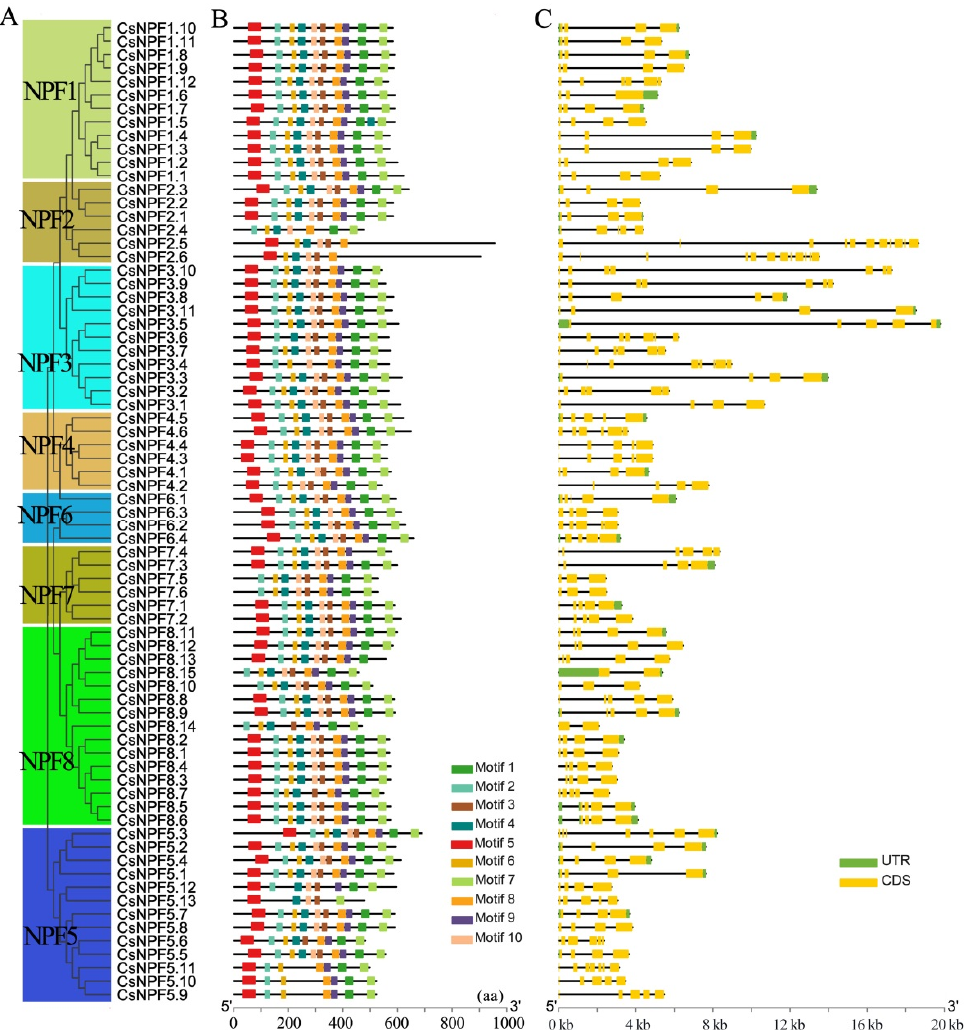
Figure 4. Gene structure and conserved motif compositions of CsNPF genes. ( A ) Phylogenetic tree of CsNPFs. ( B ) Conserved motifs of CsNPF proteins. The motifs 1–10 are displayed in different colored boxes. ( C ) Gene structure of CsNPF genes. The green and yellow squares represent the untranslated region (UTR) and coding sequences (CDS), respectively.